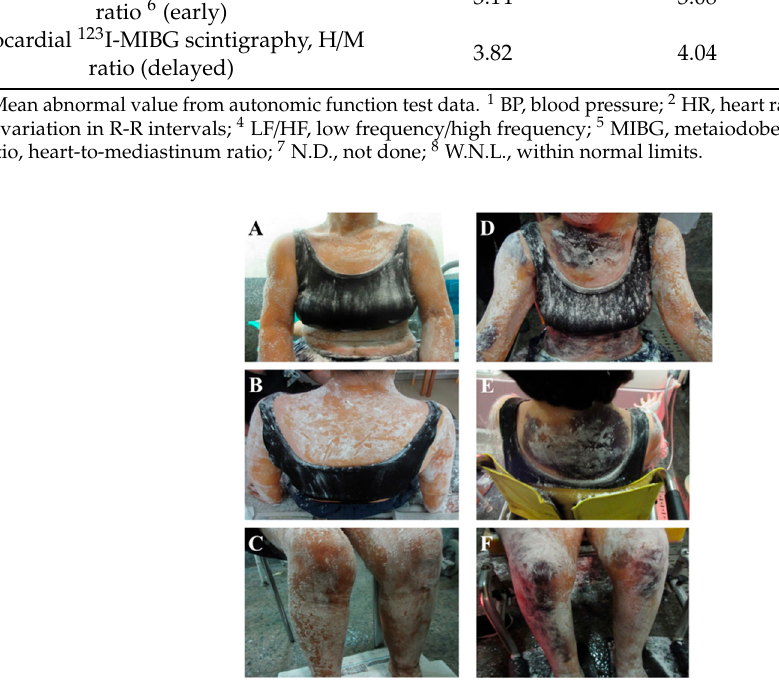
Figure 1. Thermoregulatory sweat test in Patient 1 ( A – C ): Pre-immunotherapy, ( D – F ): Post-